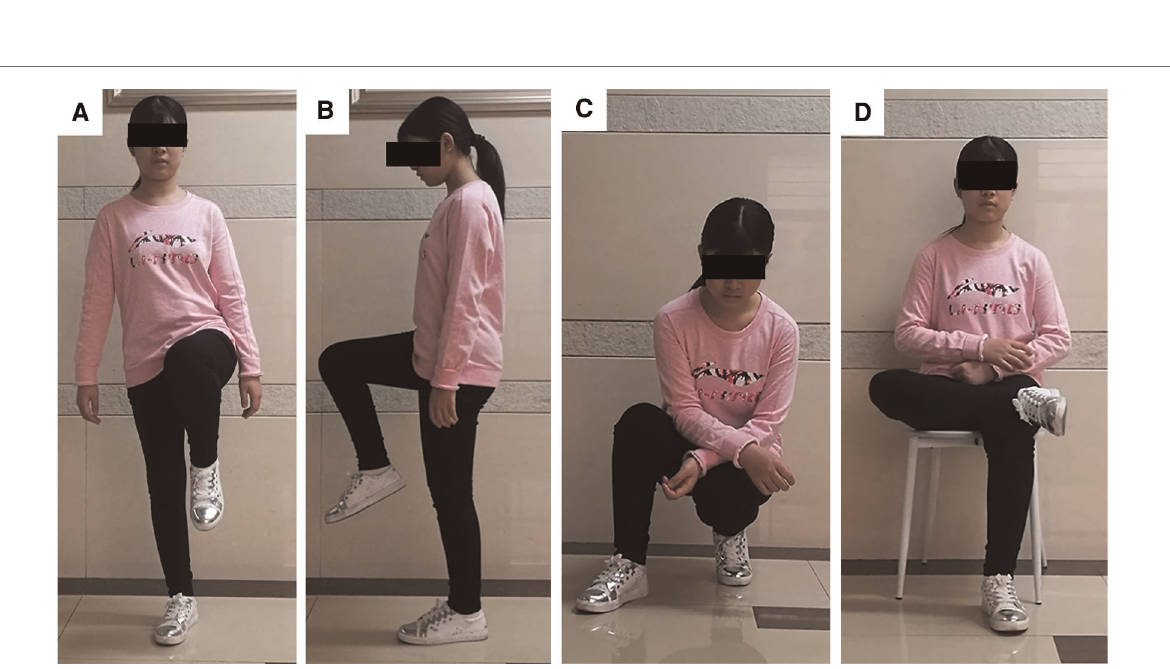
FIGURE 5 Limb function after INCS reconstruction at the postoperative 6th month of case. ( A ) This patient could stand up just with affected limb without any pain; ( B ) The knee and hip fl exion of this patient was normal; ( C ) This patient could squat and stand up without any dif fi culty; ( D ) This patient could cross legs without any pain. (INCS: intra-neck curved